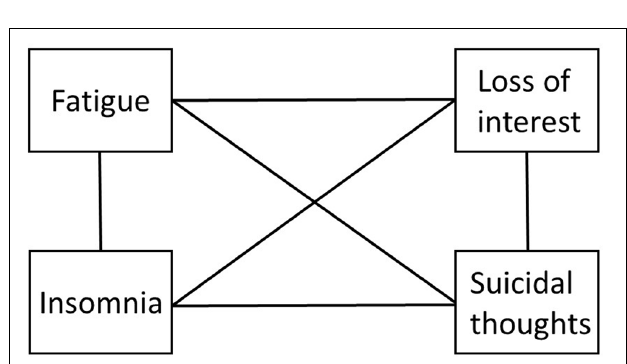
FIGURE 2 | An illustration of Depression using a Network Analysis